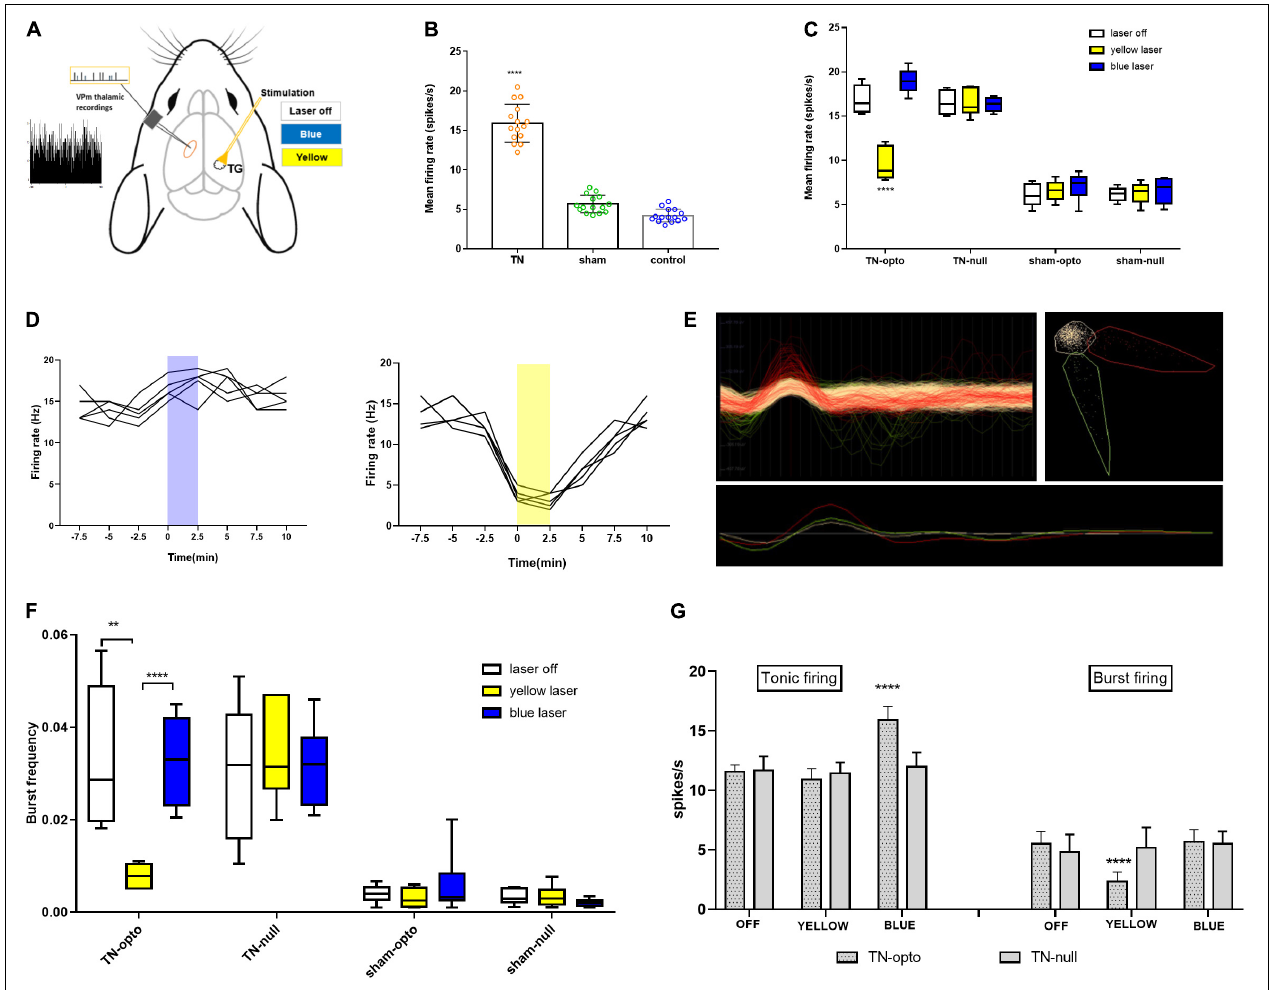
FIGURE 2 | In vivo extracellular recording from the VPm thalamus in response to TG optogenetic modulation. (A) Schematic diagram for in vivo recording. (B) Mean firing rate comparison between the groups (in spikes per second). (C) Mean firing rate from the VPm thalamus between the TN (opto and null) and sham (opto and null) groups inresponse to different stimulation states (laser off, yellow laser, and blue laser) in the TG. (D) Representative firing rate (in Hertz) during blue and yellow laser stimulation in the TN-opto group. (E) Representative cluster sorting from different waveforms in spike sorter software. (F) Burstfrequency comparison between TN (opto and null) and sham (opto and null) groups in response to different stimulation states (laser off, yellow laser, and blue laser) in TG. (G) Tonic and burst firing (spikes per second) comparisons between the TN-opto and TN-null groups in response to different stimulation states (laser off, yellow laser, and blue laser) in TG. Data are presented as the mean ± SD. **P < 0.01, ****P < 0.0001 compared to other groups